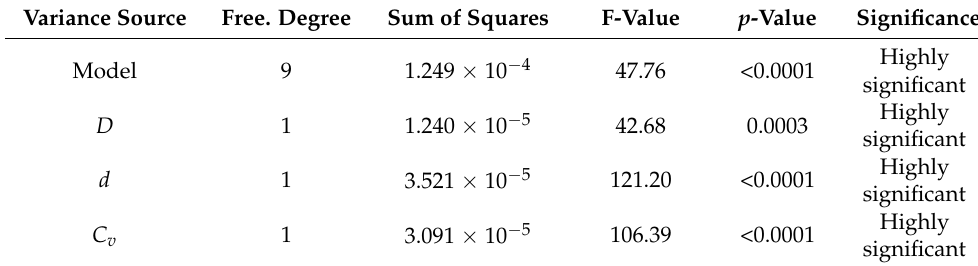
Table 6. Variance analysis of the response function model of viscosity.